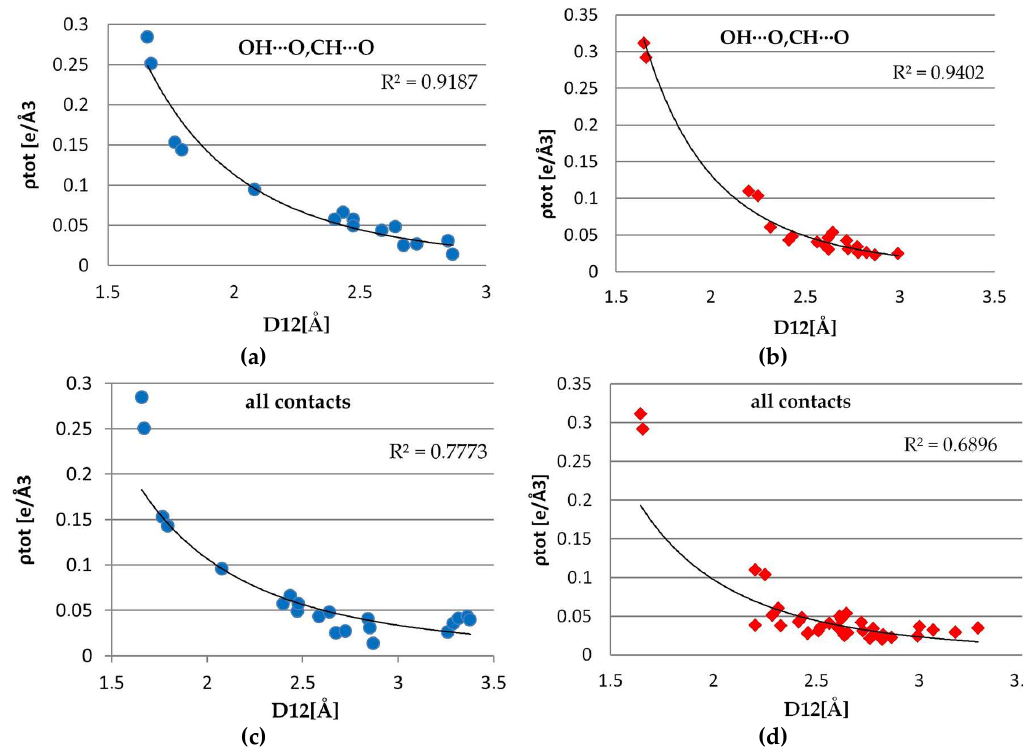
Figure 13. Plots of ρ (CP) vs. R ij for intermolecular interaction OH ··· O, CH ··· O in 1 ( a ), in 2 ( b ) and for all interactions in 1 ( c ) and in 2 ( d